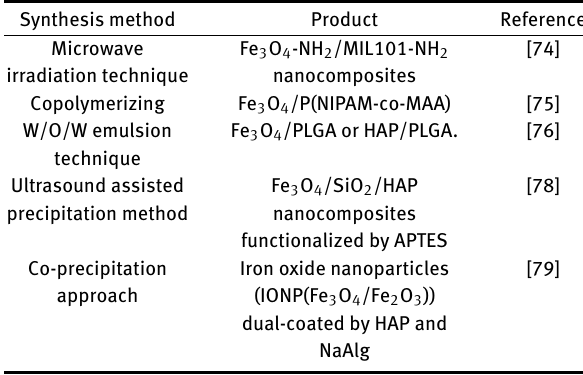
Table 8: Synthesis method of iron oxide nanoparticles in the field